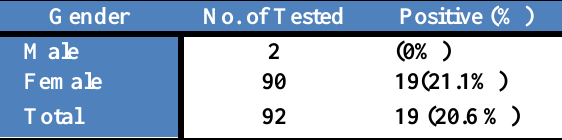
Table, 3: Prevalence of T.gondii in camels by using ELISA according to Gender.